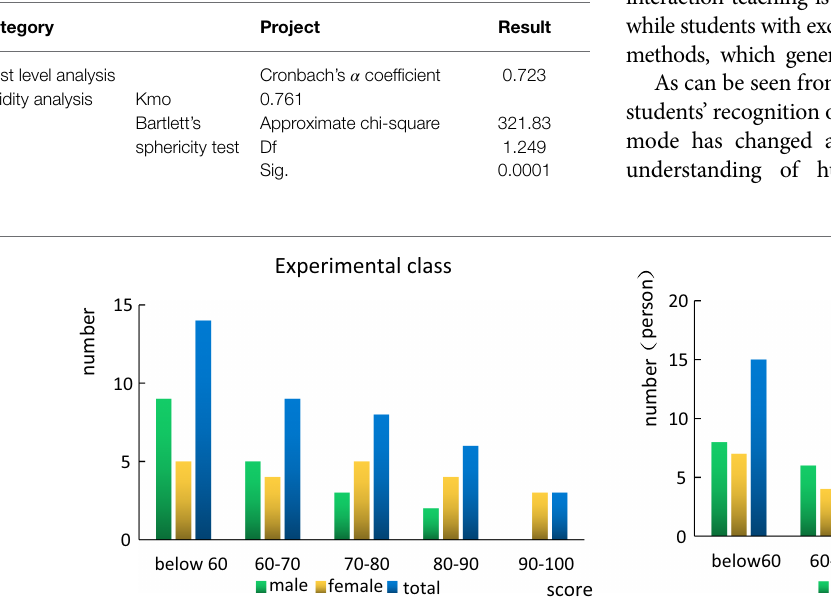
TABLE 3 | Questionnaire reliability and validity test.